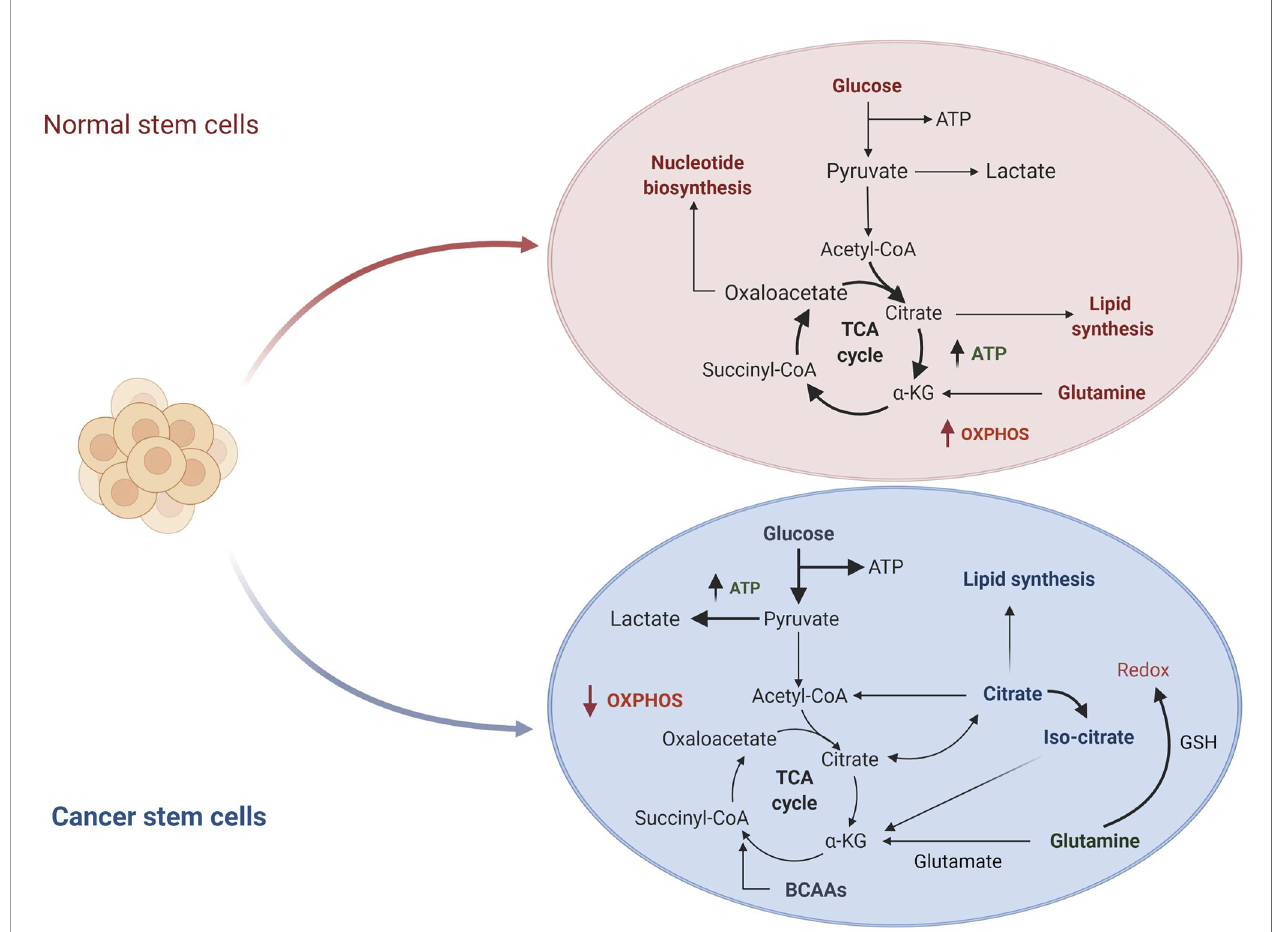
FIGURE 1 | Comparison of normal stem cells versus cancer stem cells metabolism. In normal cells, glucose is converted to pyruvate and then oxidized to Acetyl- CoA in the mitochondrial TCA cycle. Other substrates, including lipids and nucleotides, are produced from these catabolic reactions. The majority of ATP is produced by oxidative phosphorylation (OXPHOS) (not shown in the fi gure). In cancer cells, glucose uptake and glycolysis are strongly increased. Part of pyruvate is converted to lactate, while the remaining is converted to Acetyl-CoA to enter in the TCA cycle where it is converted to citrate. The produced citrate is secreted from the mitochondria for fatty acid synthesis that are necessary for structural maintenance of the membrane. TCA, tricarboxylic acid cycle; a KG, a -KetoGlutarate; GSH, glutathione; BCAAs, branched-chain amino acids. Figure modi fi ed from De Berardinis et al.